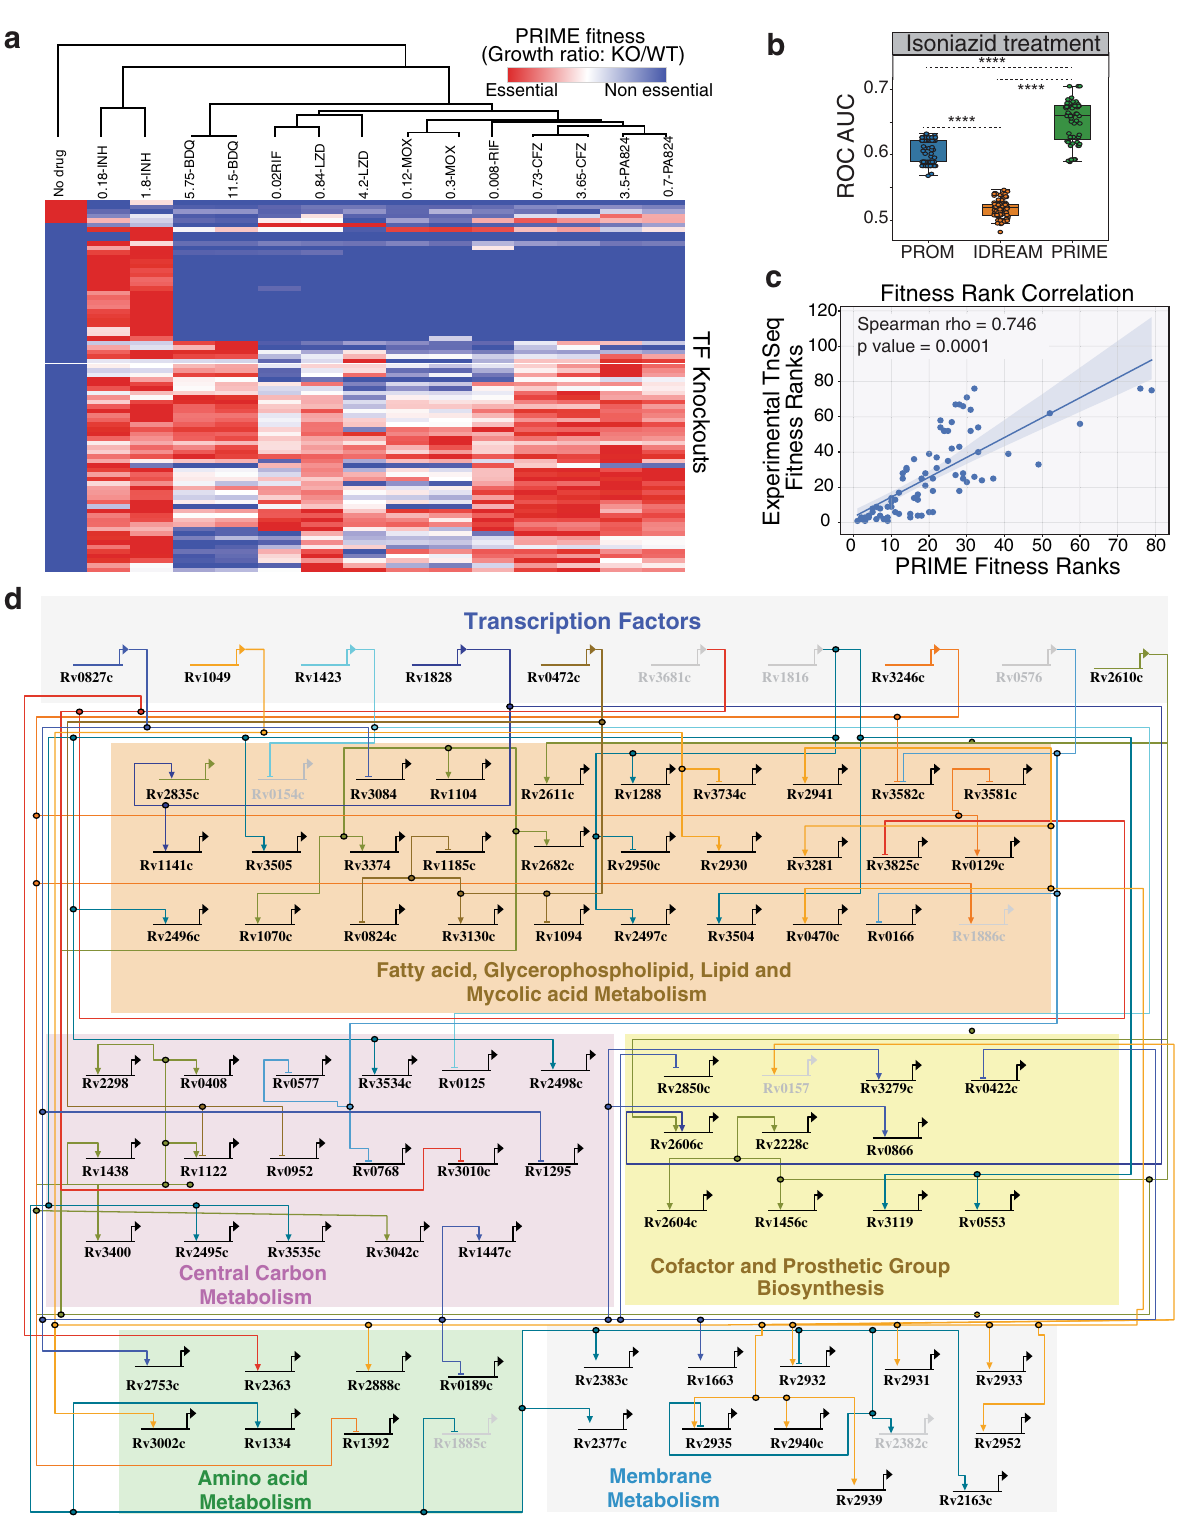
identi fi ed the speci fi c metabolic reactions that were mechan- istically responsible for the conditional essentiality of 23 TFs validated by TnSeq data 34 to be essential in the presence of INH. For example, we discovered the mechanisms underlying the essentiality of Rv0827c, Rv1049, Rv1423, Rv1828, and Rv0472c for growth in the presence of INH (Fig. 4d). Altogether,